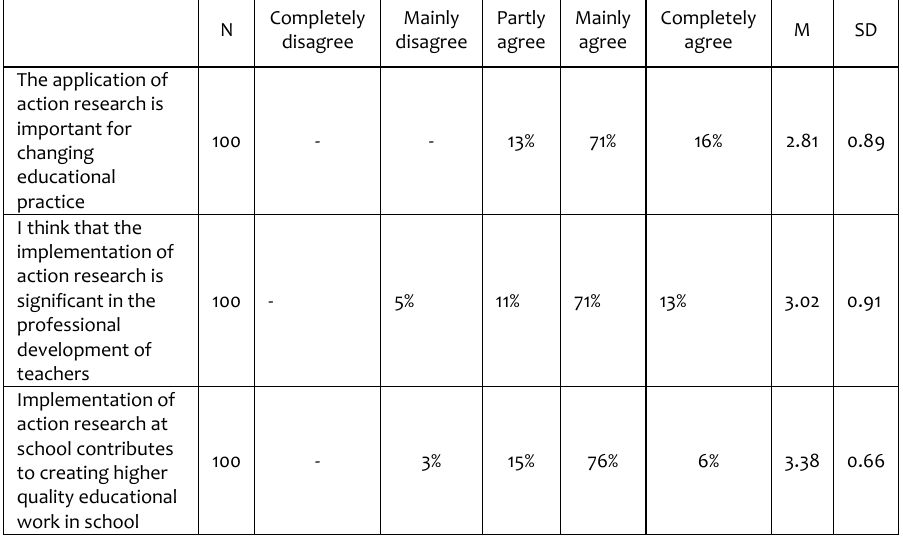
Table 5: Significance of implementation of action research for changing educational practice